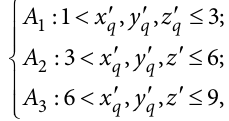
their hygroscopicity in standard intermodal containers.